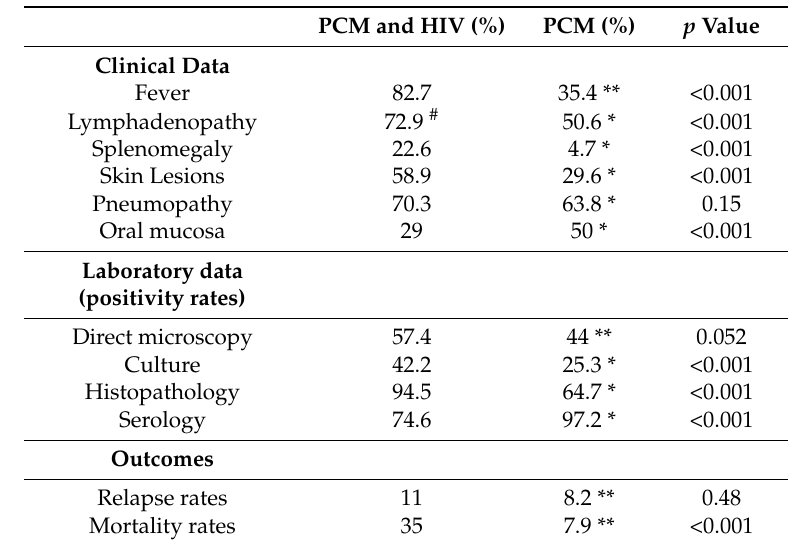
Table 1. Comparison of clinical, laboratory and outcome data from adult patients with paracoccidioidomycosis coinfected and non-coinfected with HIV